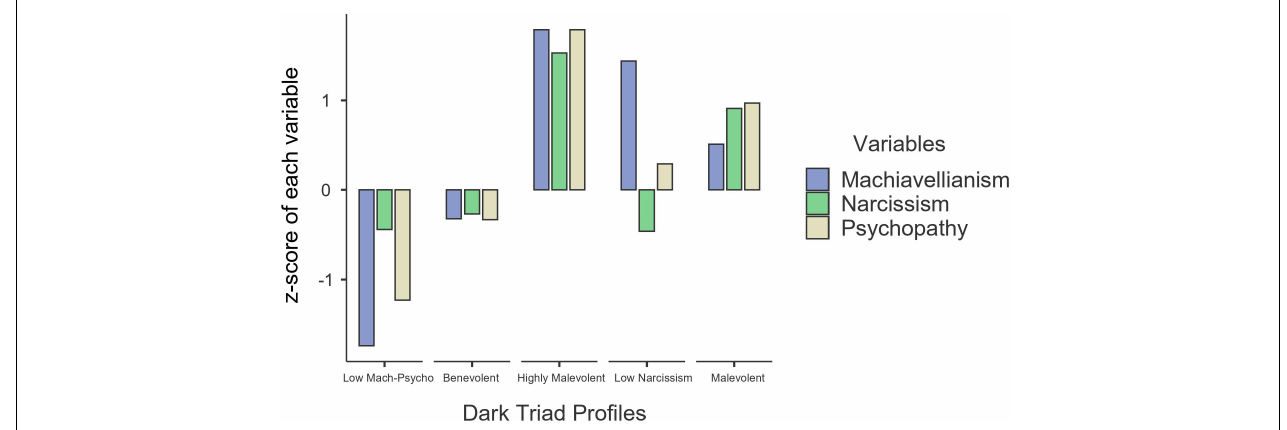
FIGURE 2 | Five personality profiles based on the z -value of three Dark Triad traits. N = 1,640. Mach-Psycho =